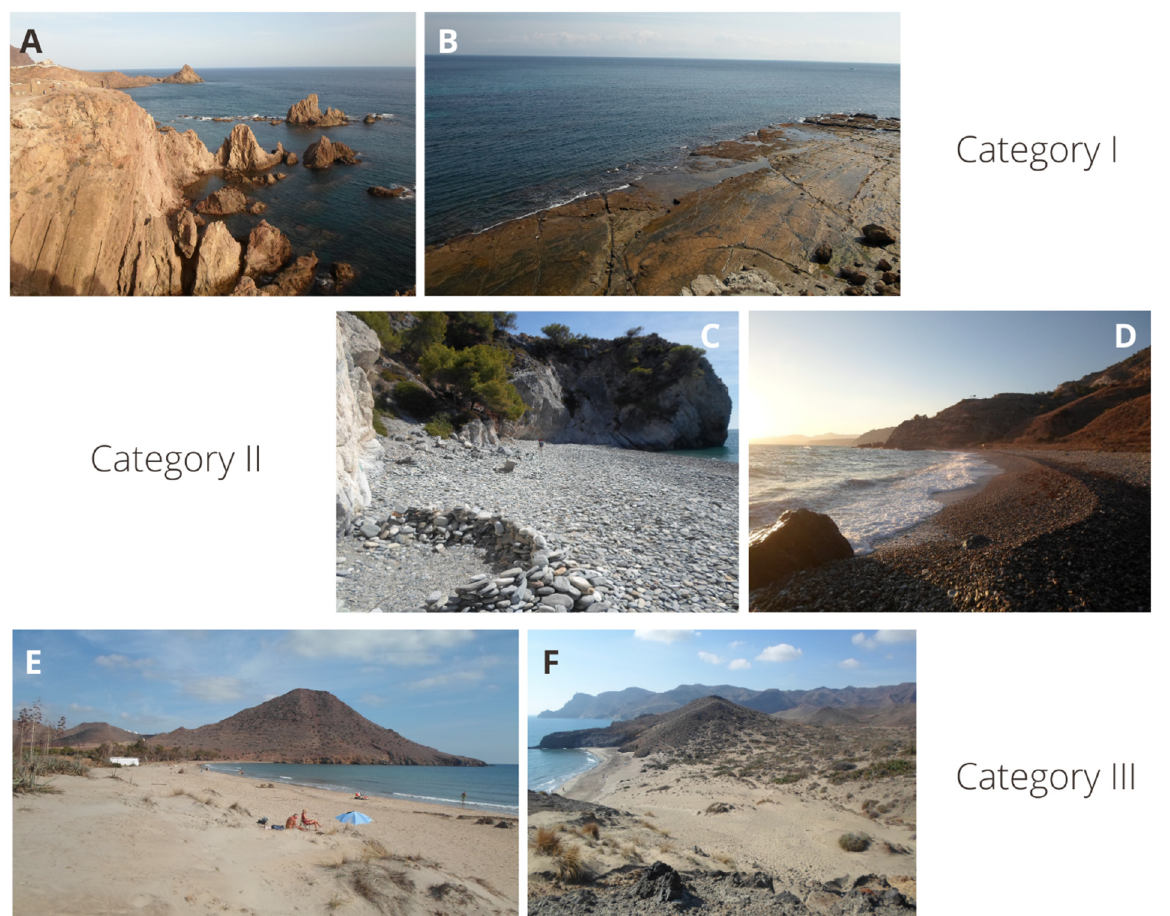
Figure 6. Examples of natural scenic categories in the Andalusia Mediterranean coast (Spain): Arrecife de Las Sirenas ( A ; Almería province) and rocky shore platform at Gibraltar Strait ( B ; Cadiz province); Cantarrijan ( C ; Granada province) and Cala del Pino ( D ; Malaga province); Los Genoveses ( E ) and Barronal ( F ) at Cabo de Gata in Almeria province.